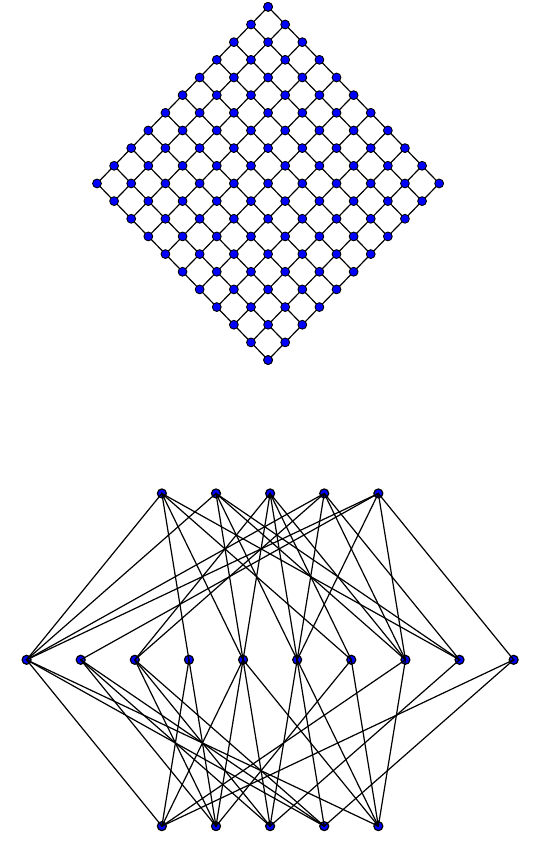
Fig. 5 Top: a regular lattice of 11 2 = 121 points. All paths in a square lattice have the same length, k = 20 in this case. Bottom: a 20-element causal set illustrating the Kleitman-Rothschild limit, with all k = 2